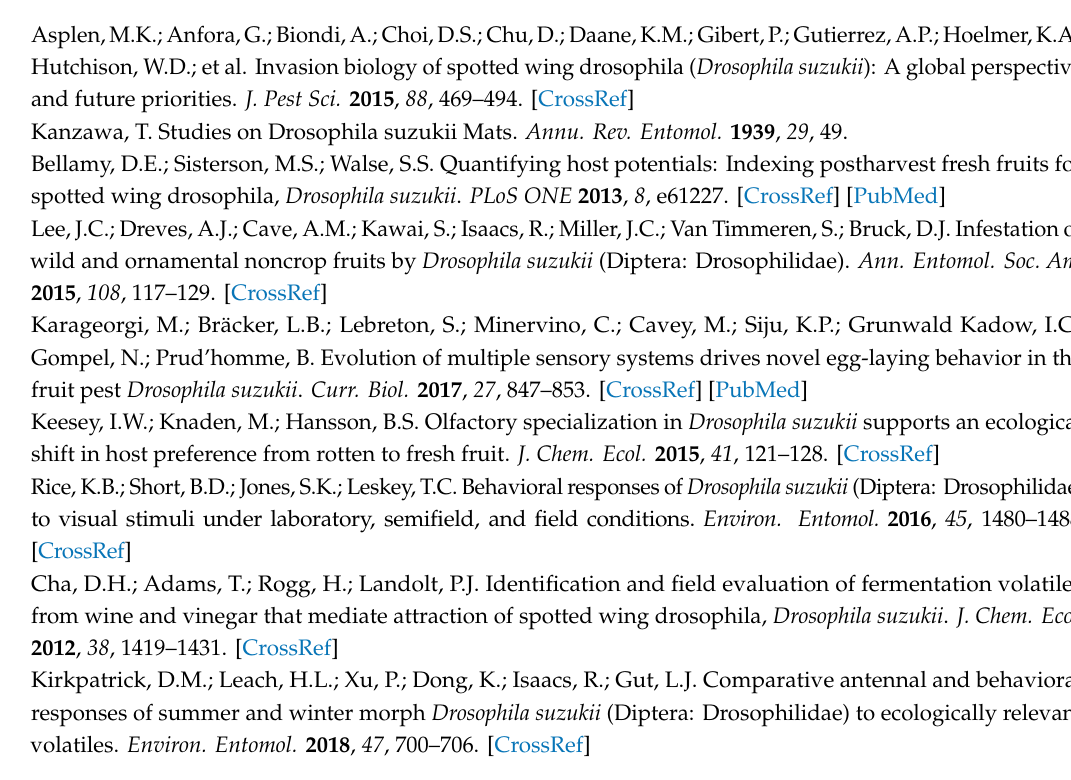
Figure S1: GC-MS Analysis of Nepeta cataria Essential